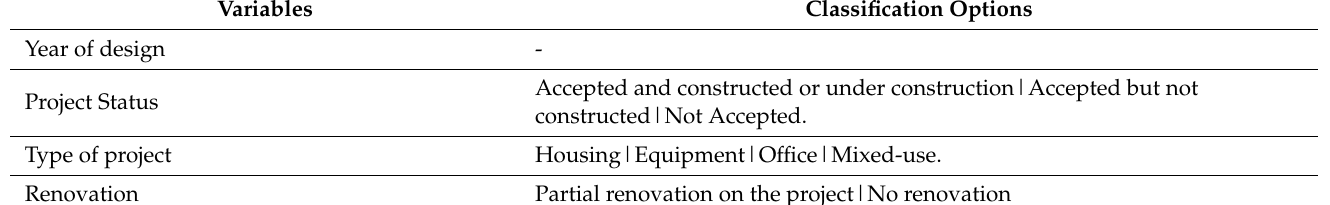
Table 2. Collected data from the original factsheets with the classification options used in the study.